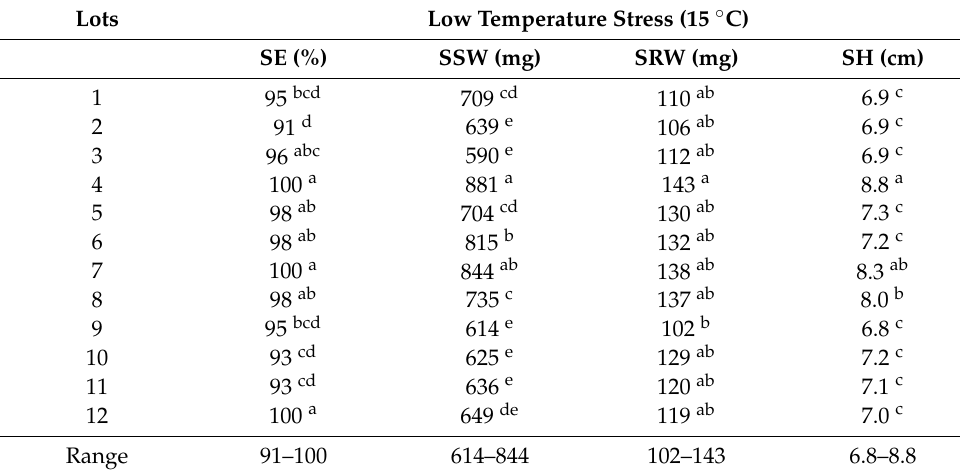
Means with different letters are significant at the 5% level in each column.